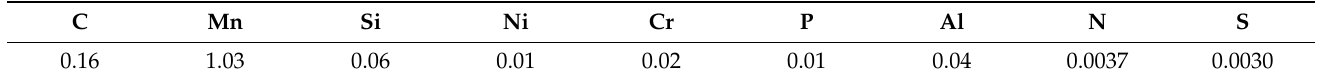
Table 1. Chemical composition, mass-%. All other elements are residual.